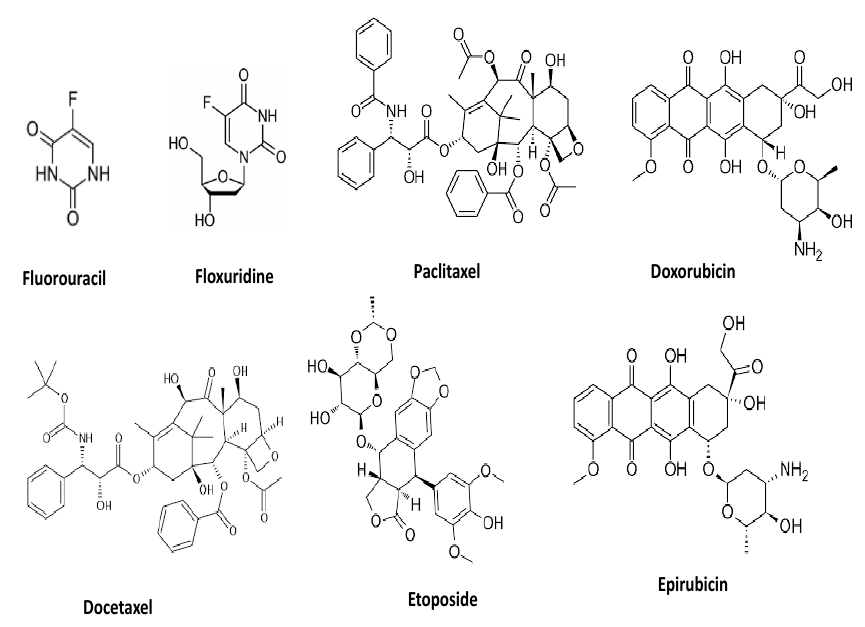
Figure 5. Chemical structure of clinical anti-cancer drugs.